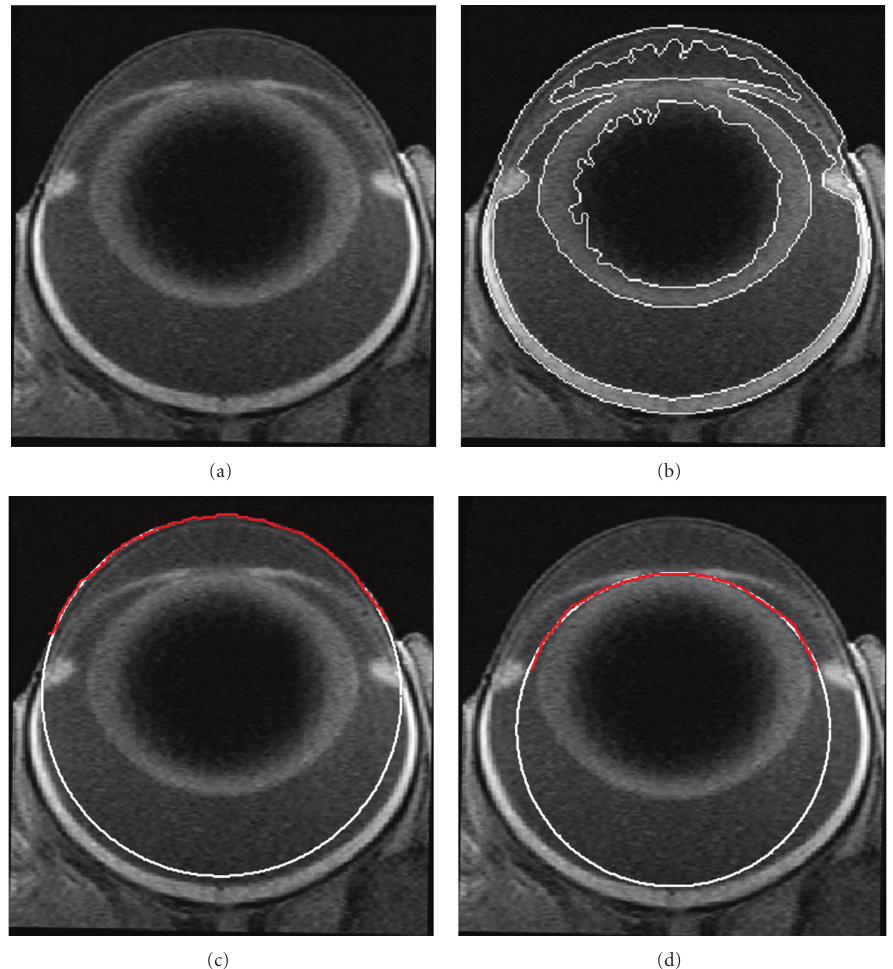
Figure 2: (a) MR image of a Long-Evans control rat P50. (b) The same image with the detected edges. (c) Circle ( white ) fit to the edge data of the anterior cornea surface ( red ). (d) Circle ( white ) fit to the edge data of the anterior lens surface ( red